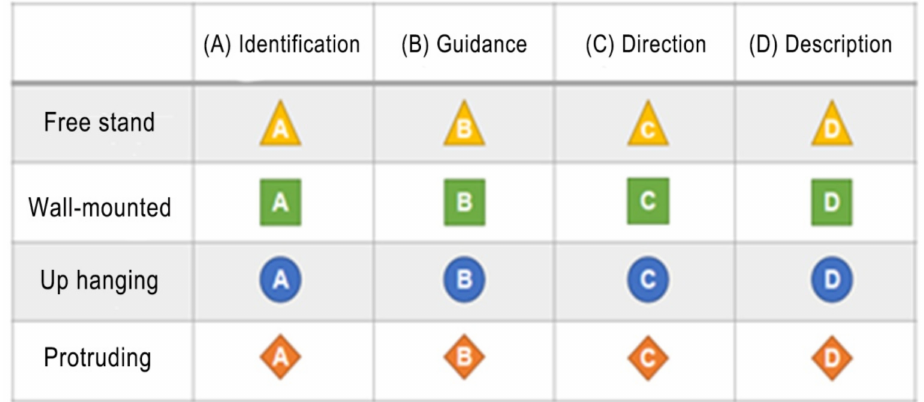
Figure 3. Classification of the content of the signage in the research field.